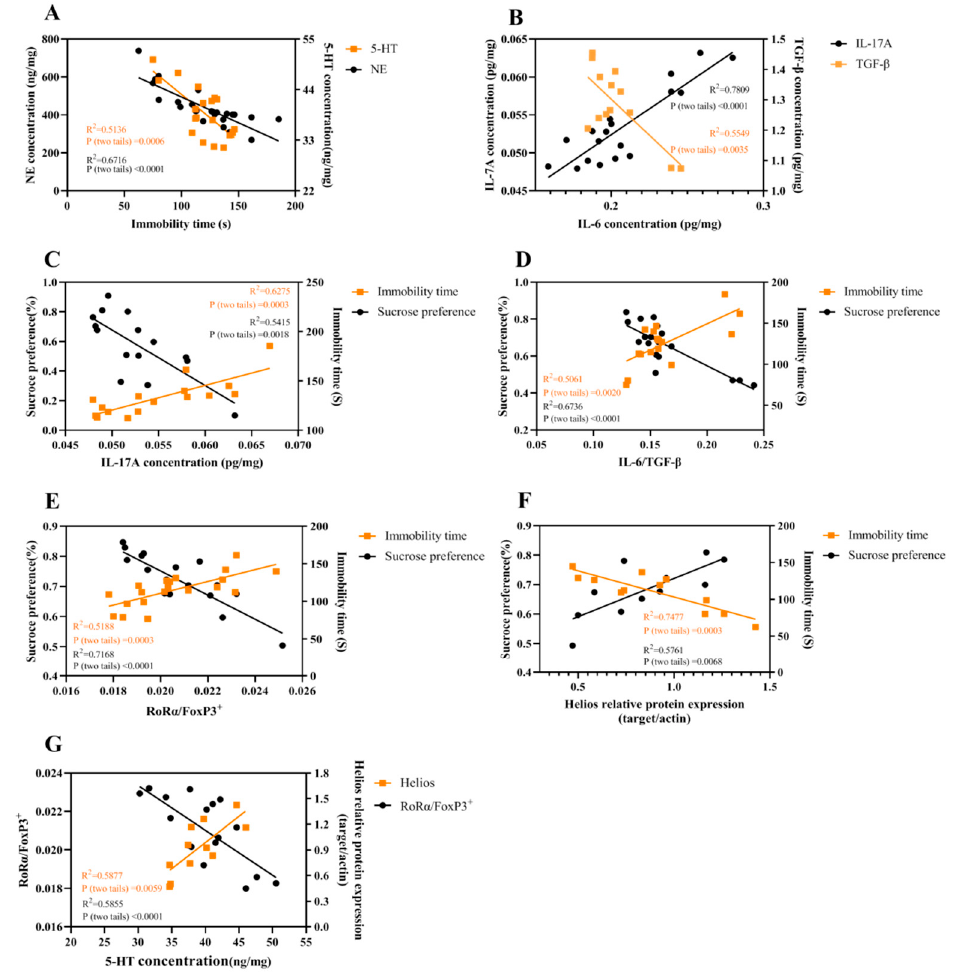
Figure 8. The correlations among different parameters were analyzed. Correlations between immobility time and NE or 5-HT ( A ), between IL-6 and TGF- β or IL-17A ( B ), between IL-17A and behaviors ( C ), between IL-6/TGF β and behaviors ( D ), between Th17/Treg and behaviors ( E ), between Helios and behaviors ( F ) and between 5-HT and Th17/Treg or Helios ( G ).